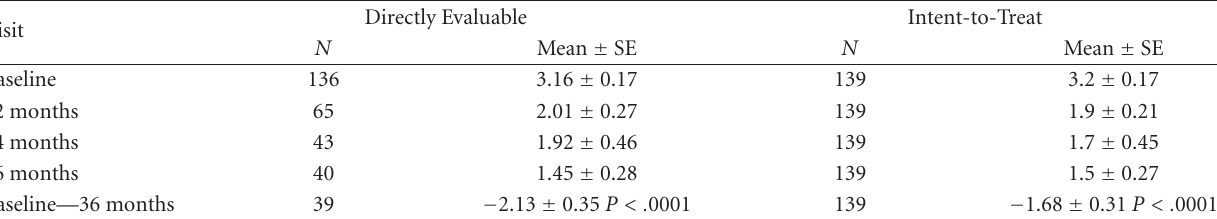
Figure 1: Patient disposition. ∗ Two validated questionnaires, the incontinence quality of life and the urogenital distress inventory instru- ments, were completed at 36 months. Table 2: Stress Leaks per day per